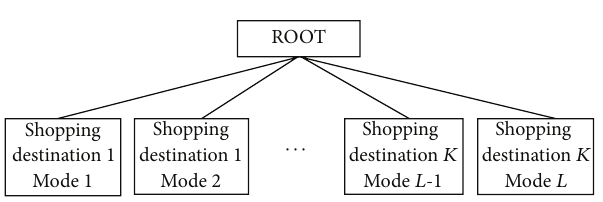
Figure 1: Structure of MNL